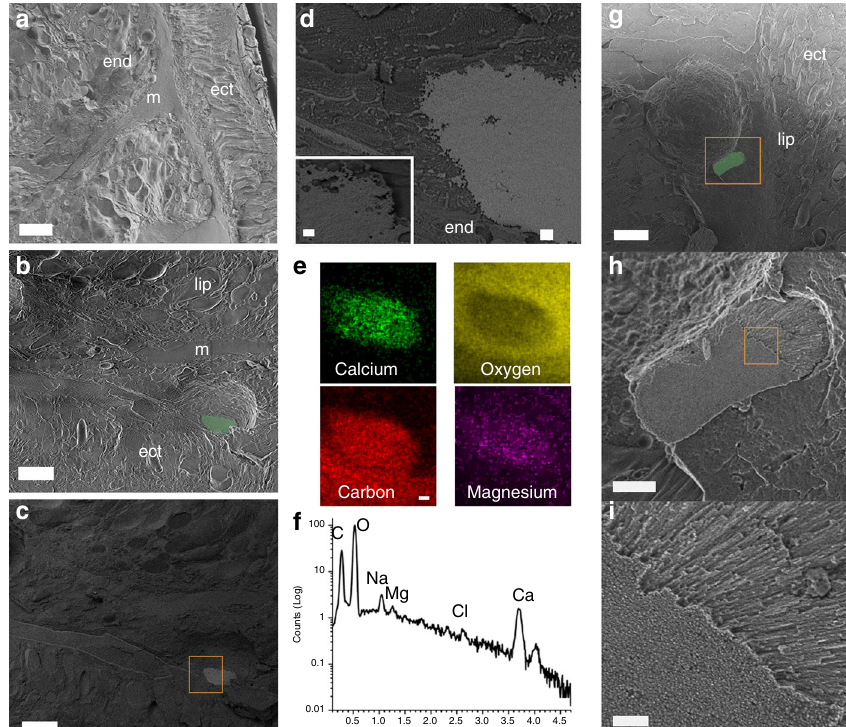
Fig. 2 Cryo-SEM images of mineral deposits at metamorphosed planula. a Top view secondary electron (SE) image of a pre-settled metamorphosed planula. b – d Early stage of mineral deposition. b SE image of a mineral deposit randomly found within the organic material of the endoderm and lipidic region. The mineral deposit is ~10- µ m long. It is digitally colored in green based on the backscattered electron (BSE) image in c . c BSE image of the same region as in b . d Higher magni fi cation of the region depicted by an orange box in c , showing the mineral deposit morphology and the interface with the organic material of the tissue. The mineral is composed of nanogranular particles as can be seen in the insert in d . e Cryo-EDS maps of the mineral deposit in b , showing the distribution of calcium, oxygen, carbon, and magnesium in the mineral deposit and in the surrounding organic matter. f Cryo-EDS spectrum of the mineral in b . The spectrum is presented on a logarithmic scale. g – i A developing aragonite mineral embedded in the organic material of the tissue. g SEM image of a 10 µ m aragonite crystal, colored in green based on the BSE image. h SE image of the region depicted in an orange box in g , showing the mineral. i Higher magni fi cation of the region depicted in an orange box in h , showing that acicular aragonite crystals emerge from a nanogranular structure (end, endoderm; m, mesoglea; ect, ectoderm; lip, lipid gland). Scale bars: a 20 µ m; b , c , g 10 µ m; h , e 2 µ m; i 400 nm; d insert, 200